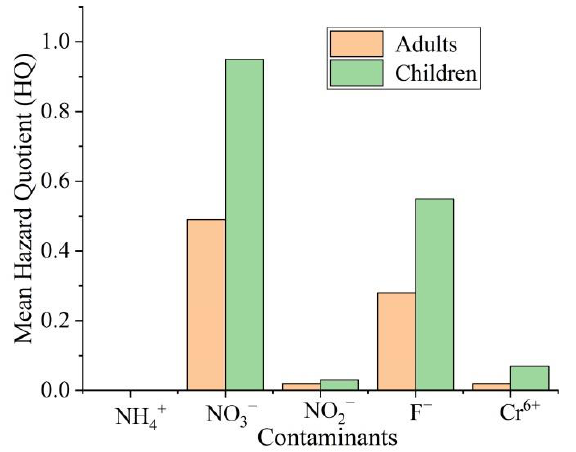
Figure 6. Representation of the mean HQ for non-carcinogenic (NH 4+ , NO 3 − , NO 2 − , F − , Cr 6+ ) contaminants. Table 7. Calculated carcinogenic risk due to Cr 6+ in water intake and dermal